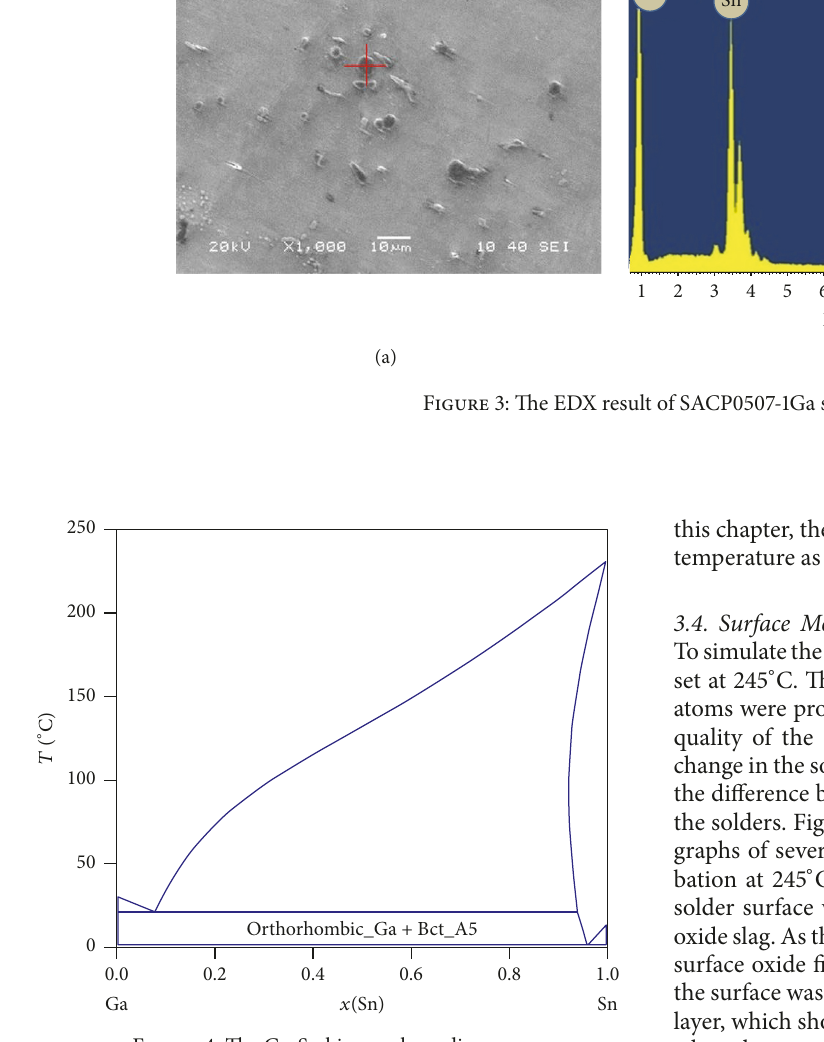
Figure 4: The Ga-Sn binary phase